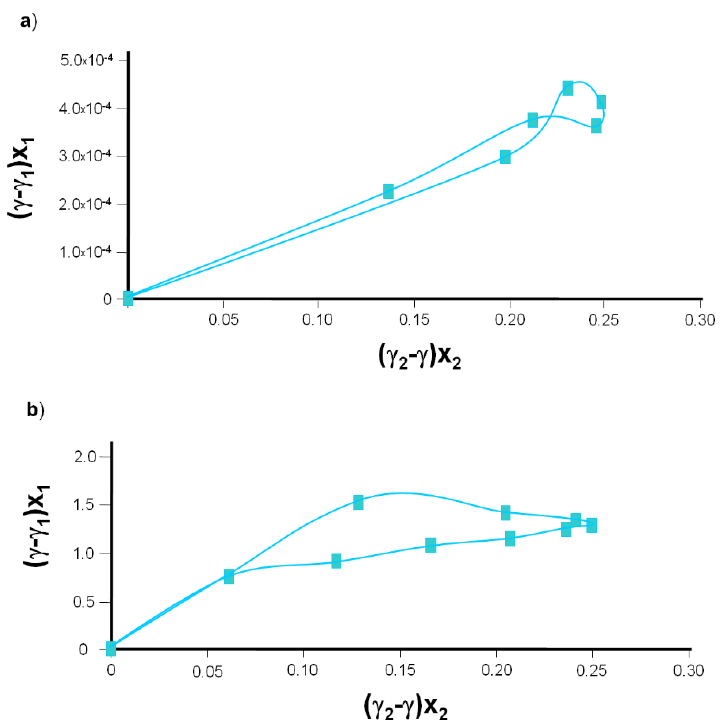
Figure3. Plotof Equation(2) forDPPC-Dio( a )and DPPC-DAc( b ), where x 1 and x 2 arethemole fractions of components 1 and 2 (DPPC and Dio or DAc, respectively), showing interfacial tension measurements. DPPC: 2-Dipalmitoyl-sn-glycero-3-phosphocholine. Dio: Diosgenin. DAc: Diosgenin